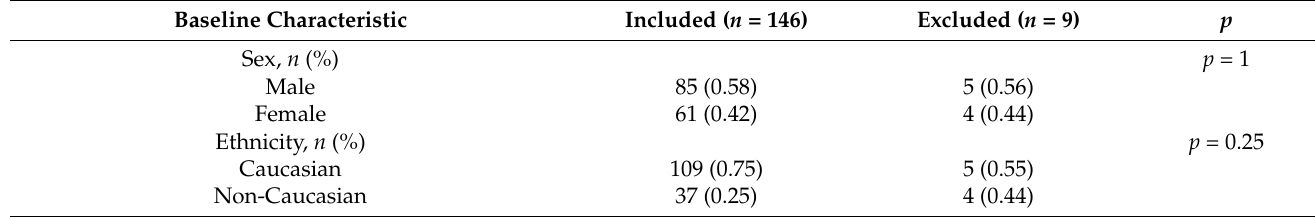
Table A1. Comparison of included vs. excluded